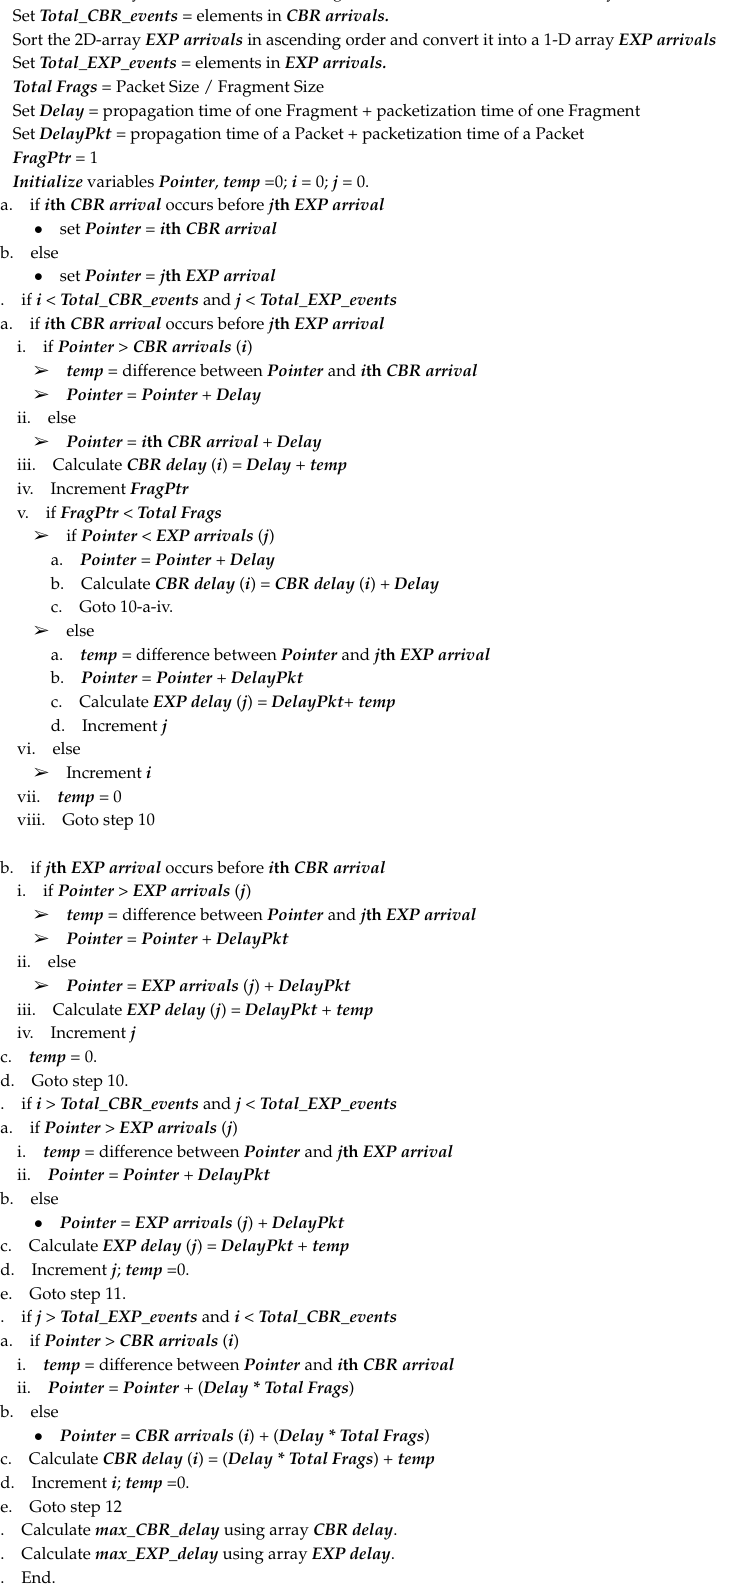
Algorithm 3. Delay Calculation for Prioritization with Fragmentation